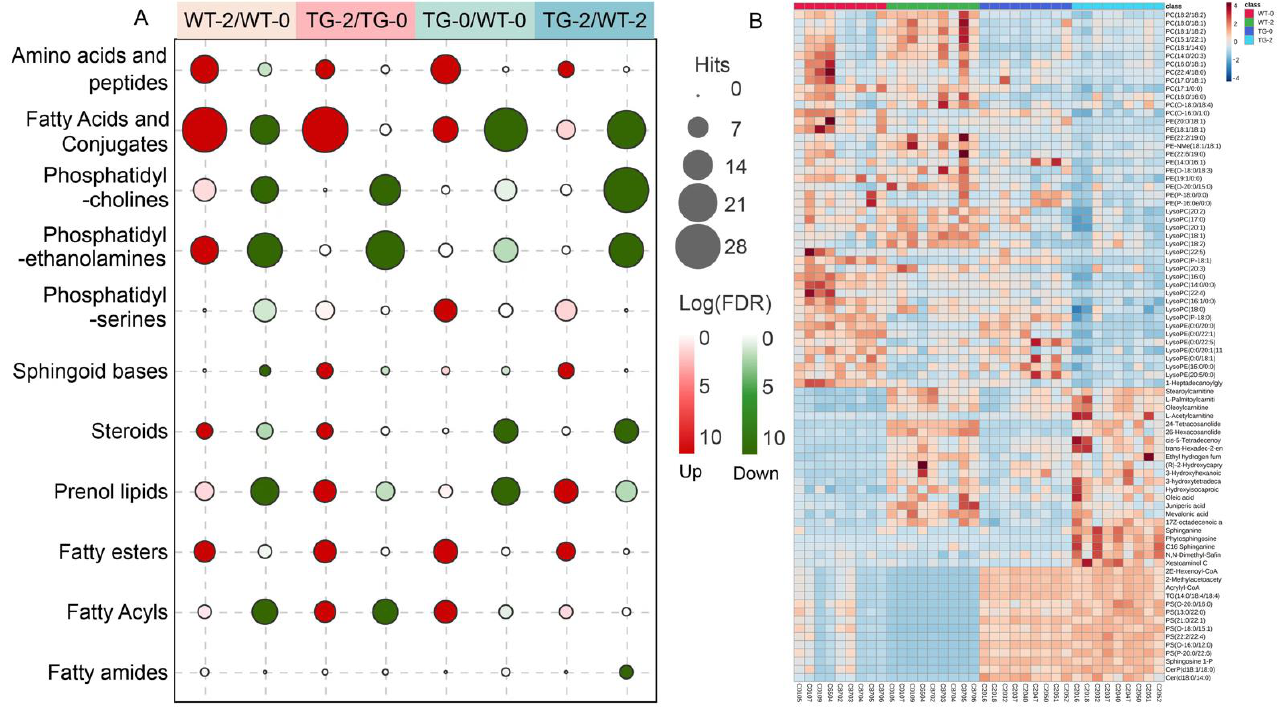
Figure 3. Enrichment analysis ( A ) and heatmap ( B ) exhibited the differential metabolites, and lipids in the four groups of pig plasma samples. PC, Glycerophosphocholines. PE, Glycerophosphoethanolamines. PS, Glycerophosphoserines.